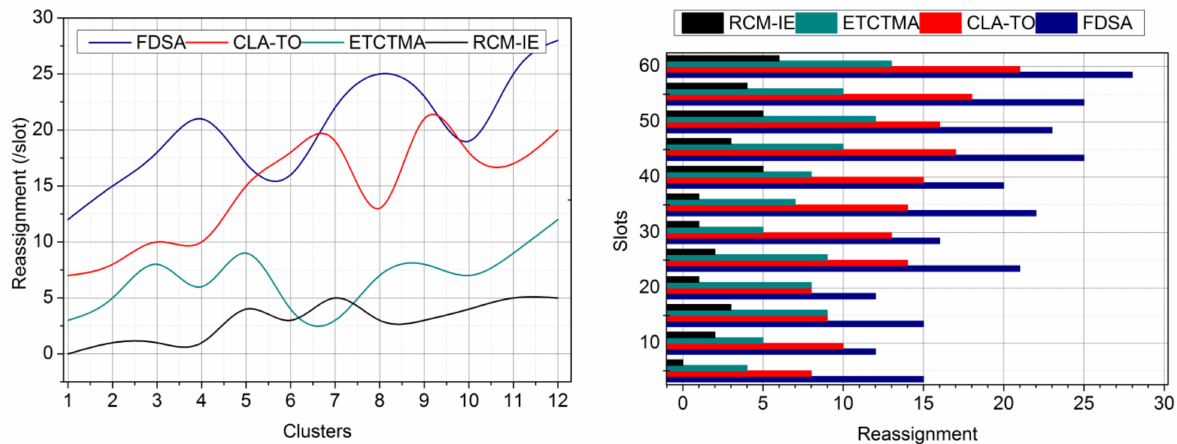
Figure 11. Reassignment